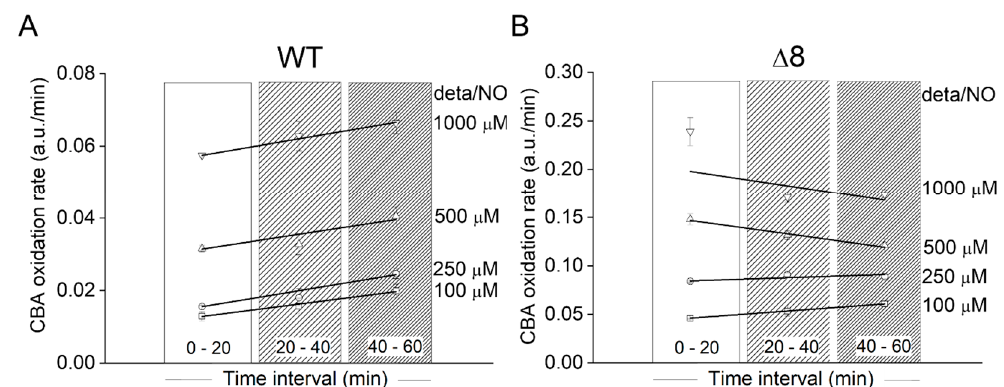
Figure 4. Rate of CBA oxidation in suspensions of WT and ∆ 8 S. cerevisiae cells as a function of the time and NO • donor concentration. ( A ) WT S. cerevisiae. ( B ) ∆ 8 S. cerevisiae . Suspensions of WT and ∆ 8 S. cerevisiae cells in 96-well plates (20 × 10 6 cells per well) containing CBA (10 µ M) were exposed to paraquat (10 µ M) and increasing concentrations of deta / NO. The rate of CBA oxidation was determined by the linear regression of the data within each time interval shown. The experimental conditions and fluorescence acquisition parameters are described in the Figure 1 legend. The data are from a representative experiment carried out in triplicate and repeated three times with similar results.